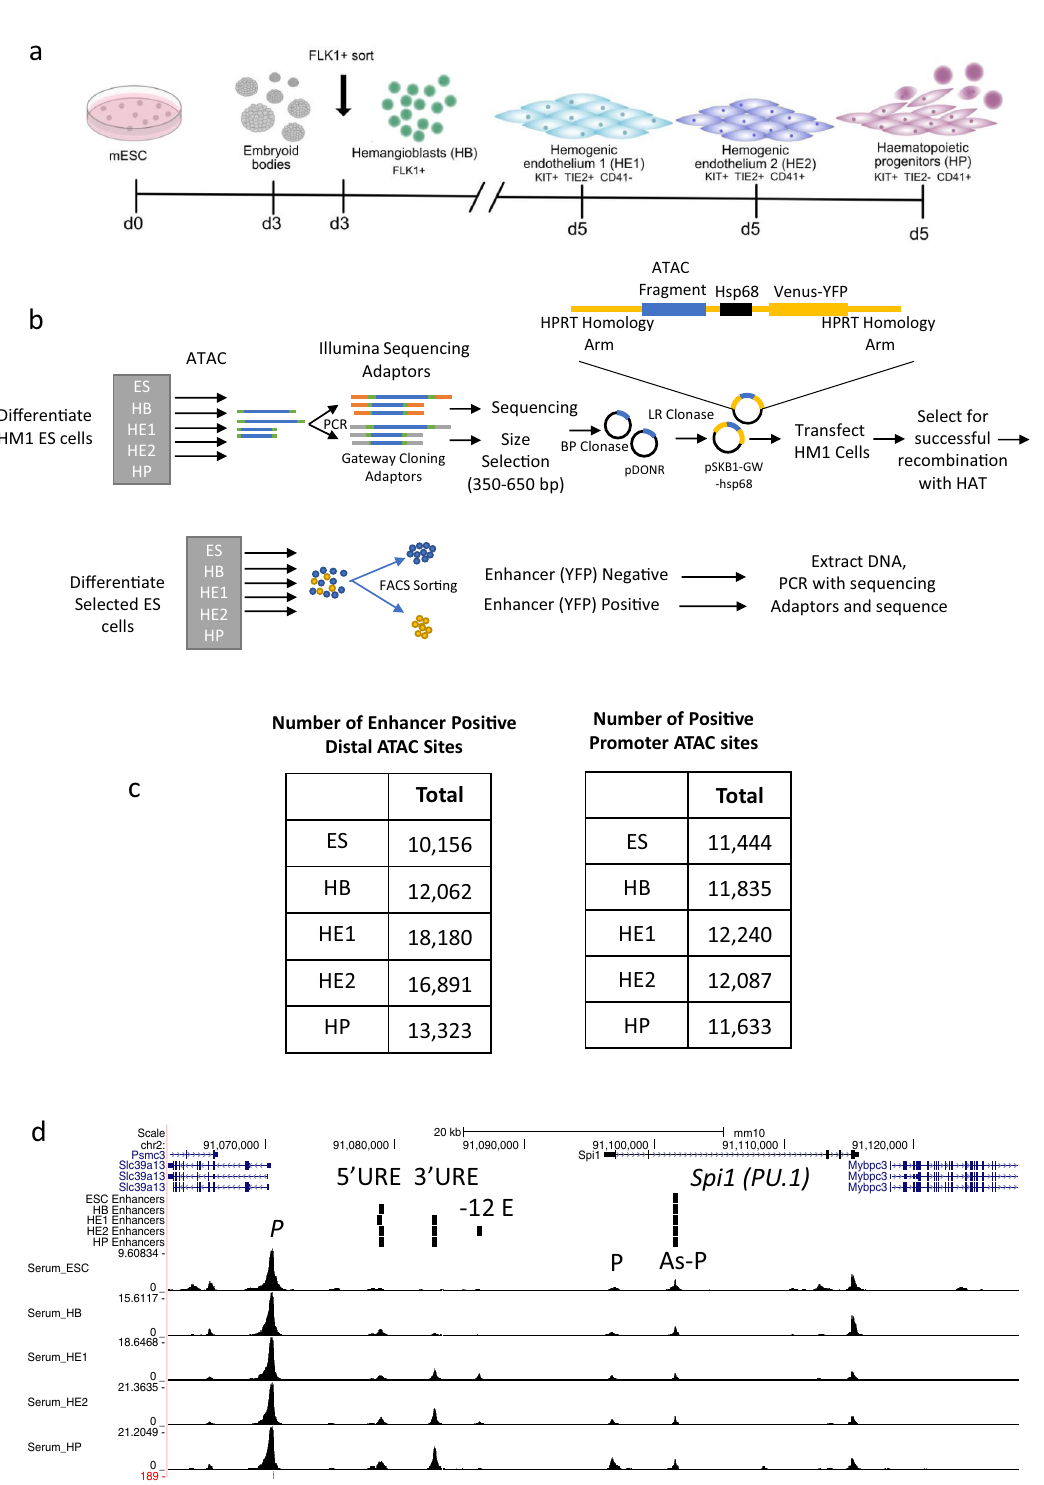
Fig.1|Establishingahigh-throughputmethodforfunctionalenhancertesting inachromatinenvironment.a DepictionoftheEScelldifferentiationsystemand the cell types analysed. b Overview of the screening procedure using ATAC-Seq fragments from 5 different cell stages. c Total number of distal and promoter ATAC-sites scoring positive in two replicates of the assay. d UCSC Browser